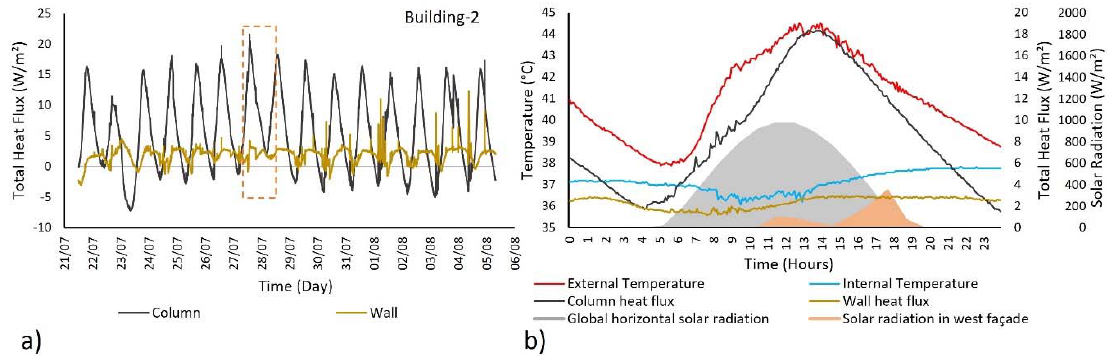
Figure 8. ( a ) Building-2 heat flux for the whole period and ( b ) selected day heat flux, external and internal temperature, and solar radiation.